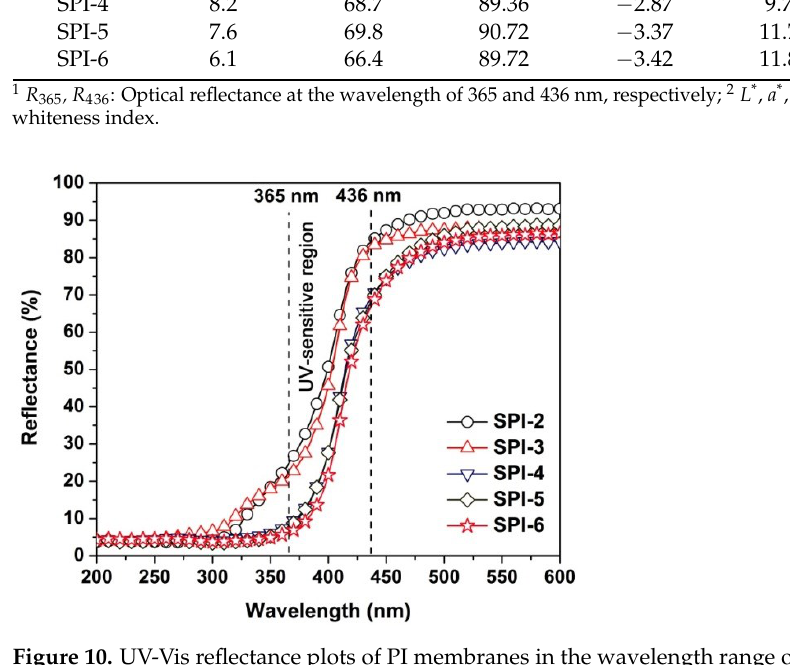
Figure 10. UV-Vis reflectance plots of PI membranes in the wavelength range of 200~600 nm. Table 4. Optical data of PI-1 and SPI